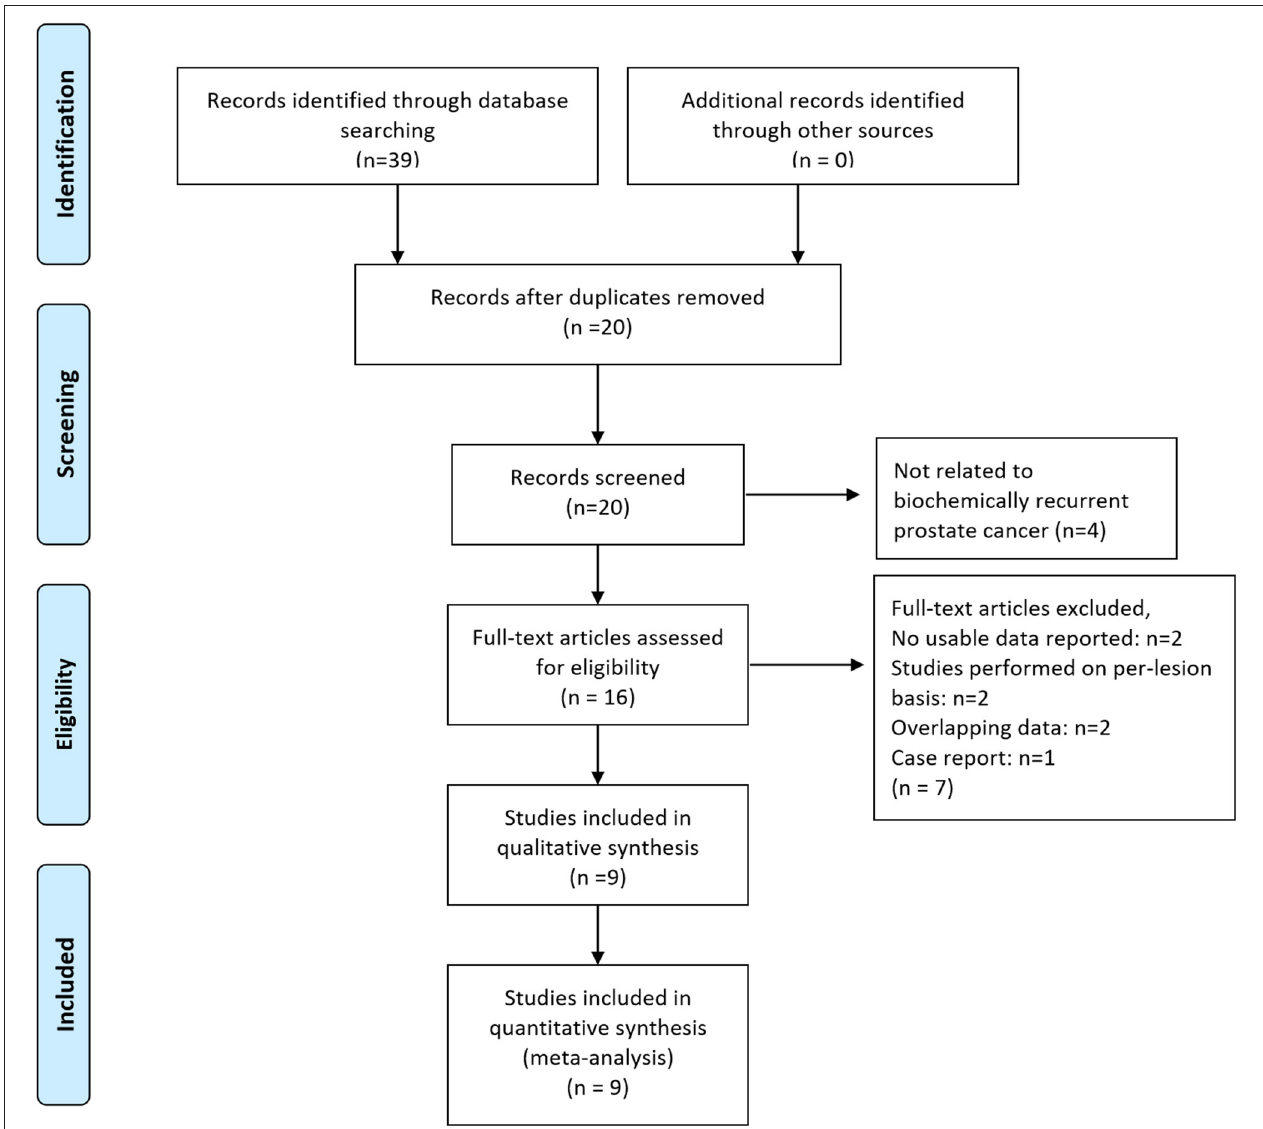
FIGURE 1 | Preferred reporting items for systematic reviews and meta-analyses (PRISMA) 2009 flow diagram. From Moher et al. (28).